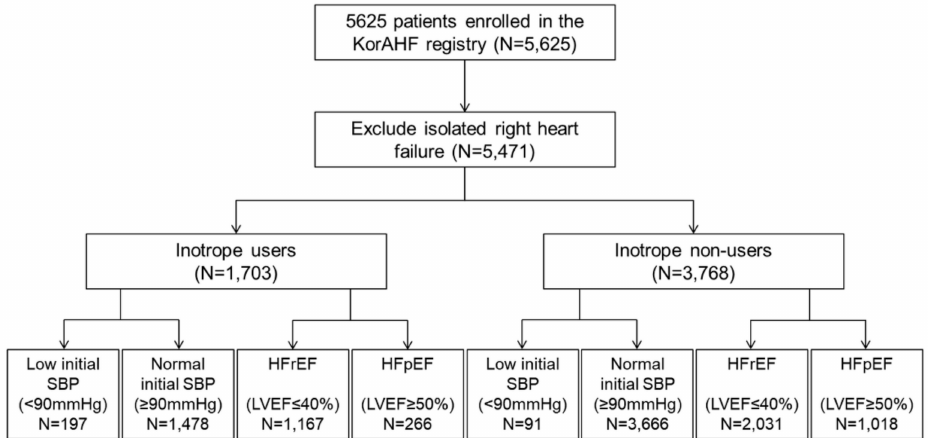
Figure 1. Flowchart of the Korean Acute Heart Failure (KorAHF) registry. Analysis was performed to evaluate the effect of inotropes in acute heart failure patients. Subgroup analysis was performed by initial SBP (low initial SBP (<90 mmHg) vs. normal initial SBP ( ≥ 90 mmHg)) LV systolic function (HFrEF (LVEF ≤ 40%) vs. HFpEF (LVEF ≥